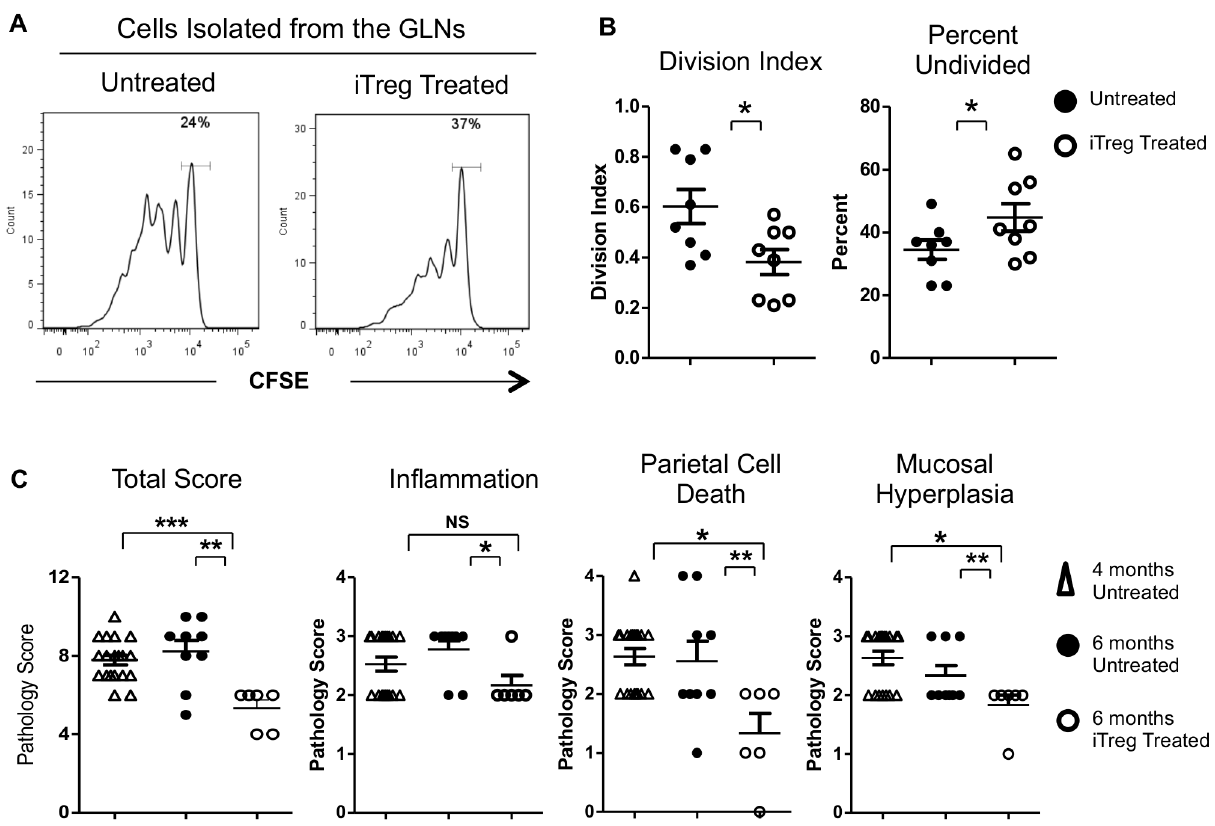
Figure 2. Treatment with iTregs suppressed effector T cell proliferation and reversed disease pathology in TxA23 mice. (A) Representative histograms of the CFSE dilution by labeled T cells transferred into untreated and iTreg mice. Data represents the mean 6 SEM of a combination of two independent experiments with 4 mice in each group. (B) Division index and percent undivided of CFSE labeled effector T cells from individual mice. (C) Pathology scores of stomachs from 4-month-old TxA23 mice, 6-month-old TxA23 mice that were left untreated, and 6- month-old mice that received 5 6 10 6 H + /K + ATPase-specific iTregs at 4 months of age. Sections from individual mice were graded on a scale of 0–4 for severity of inflammation, parietal cell death, and mucosal hyperplasia. The total pathology score is the sum of the individual scores for each individual mouse. Data for 6-month-old untreated and iTreg treated mice represents the mean 6 SEM of a combination of two independent experiments with three mice per group. Data were analyzed using a Mann–Whitney U test *p , 0.05, **p , .01, ***p , .001.